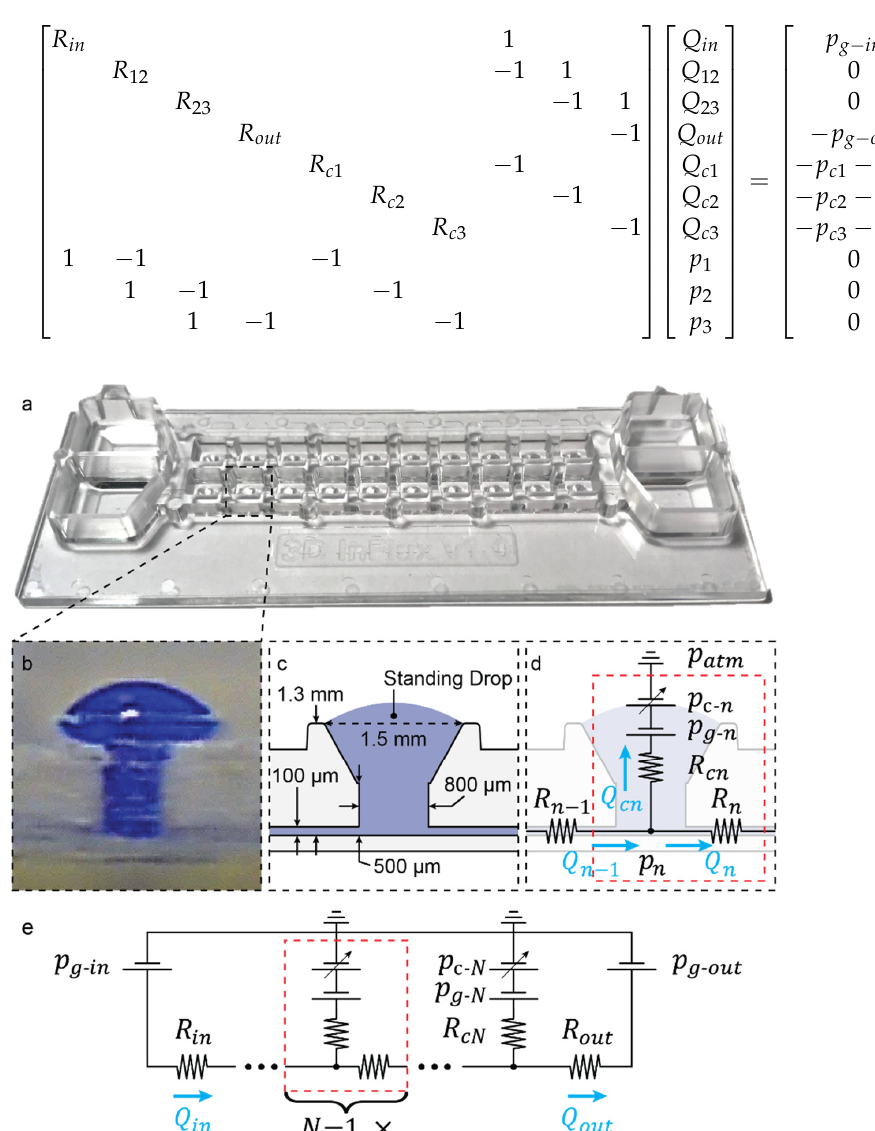
Figure 6. Circuit-based-microfluidic-network design example for a standing-drop chip configuration. ( a ) Photograph of the previously published “scalable microphysiological system” [9]. Dashed black frames represent schemes of a standing-drop compartment of the chip. ( b ) Photo of the cross section of a single compartment filled with blue-dyed water. ( c ) Schematic of a standing-drop compartment with relevant dimensions for modeling resistances and pressures. ( d ) Electrical-equivalent-circuit representation of a single standing drop. All known variables (resistances R , hydrostatic pressures p g , and capillary pressures p c ) are defined in the scheme. All unknown variables (hydrodynamic pressures p i and flow rates Q i ) are defined, and the flow directions and rates are set. A reversal of the flow direction is indicated by a negative flow rate. The dashed red frame outlines a single standing drop unit to be modeled and repeated. ( e ) Equivalent circuit of the entire “scalable microfluidic system”. The single standing drop (dashed red frame) is repeated N = 10 times for the entire chip. Known ( R in / out and p g − in / out ) and unknown ( Q in / out ) inlet and outlet variables are included to show the complete